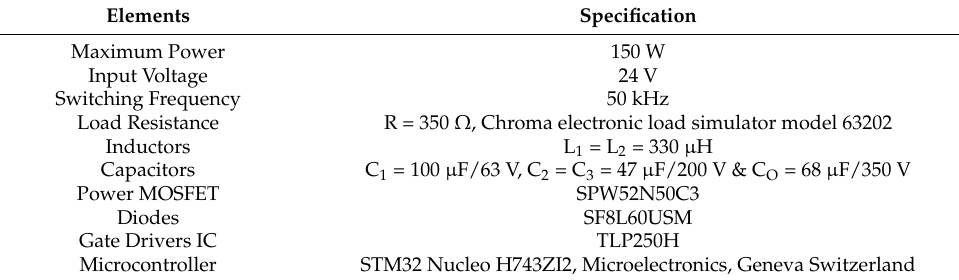
Table 4. Design specification of converter II (adapted from [31]).